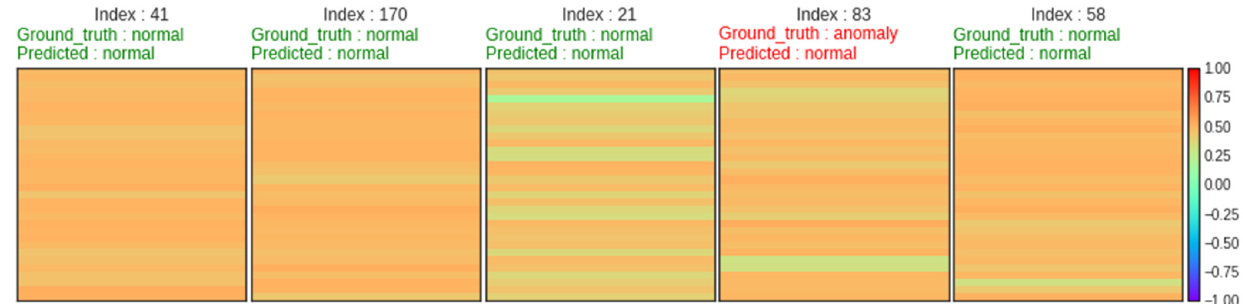
Figure 2. Slide rail data (4 K) DWT image